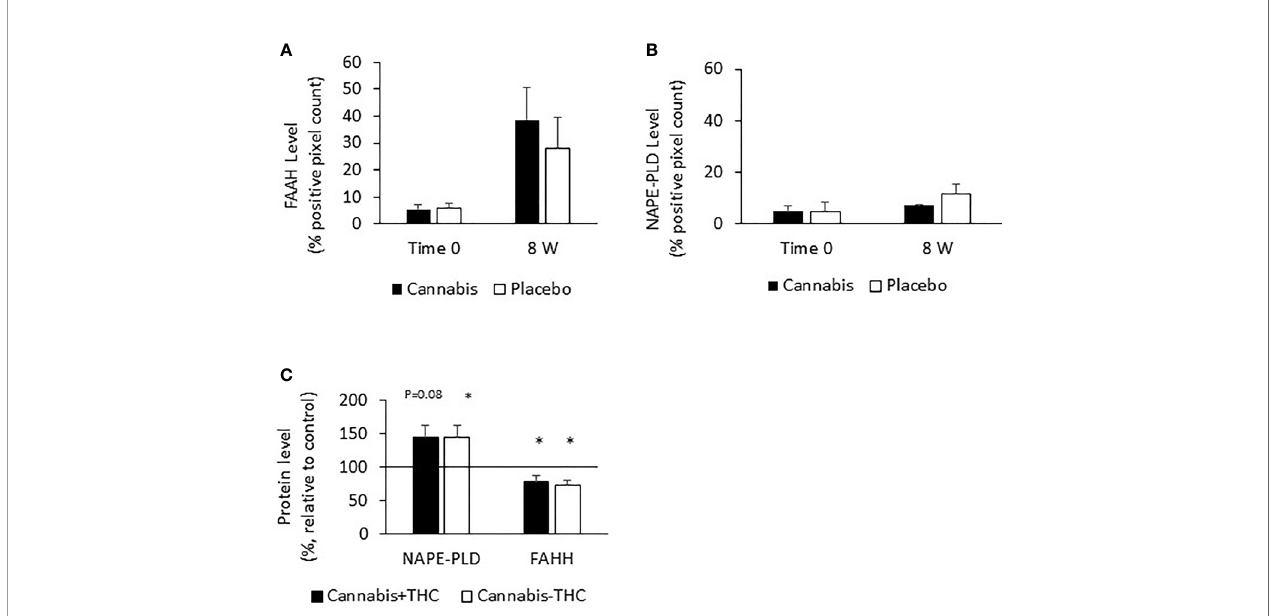
FIGURE 4 | FAAH and NAPE-PLD expression levels in colon biopsies and Caco-2 cells treated with cannabis or controls. UC patients were treated for 8 weeks with cannabis or placebo. FAAH and NAPE-PLD levels were evaluated before the beginning of the experiment and 8 weeks later by using QuPath analysis digital tool. Panel (A) represents FAAH expression levels, and panel (B) represents NAPE-PLD expression levels. (C) Caco-2 cells were treated for 48 h with cannabis with/ without THC. The cells were then harvested and their proteins extracted and evaluated for FAAH and NAPE-PLD levels. (A) *Results signi fi cantly different from time 0; (C) *results signi fi cantly different from